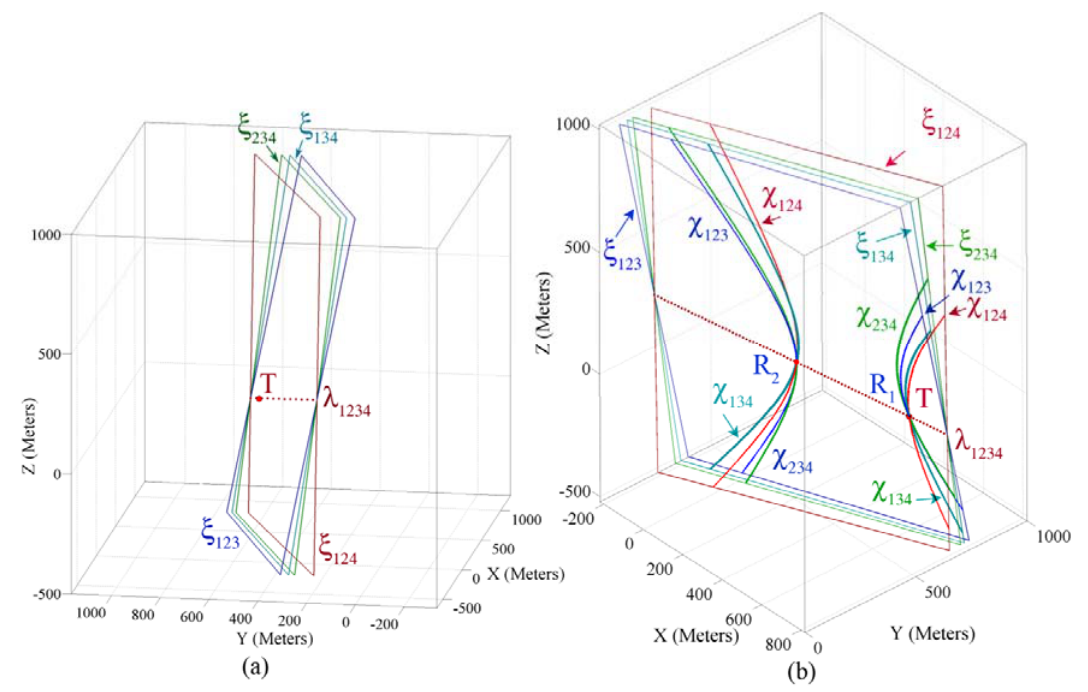
Figure 7. (a). Triple combination of four different sensing nodes’ information making a bundle of hyperplanes that pass through an axis line. (b). Intersection curves of four sensing nodes passing from two different points on the axis line of a bundle of intersection hyperplanes in the time range of [ −